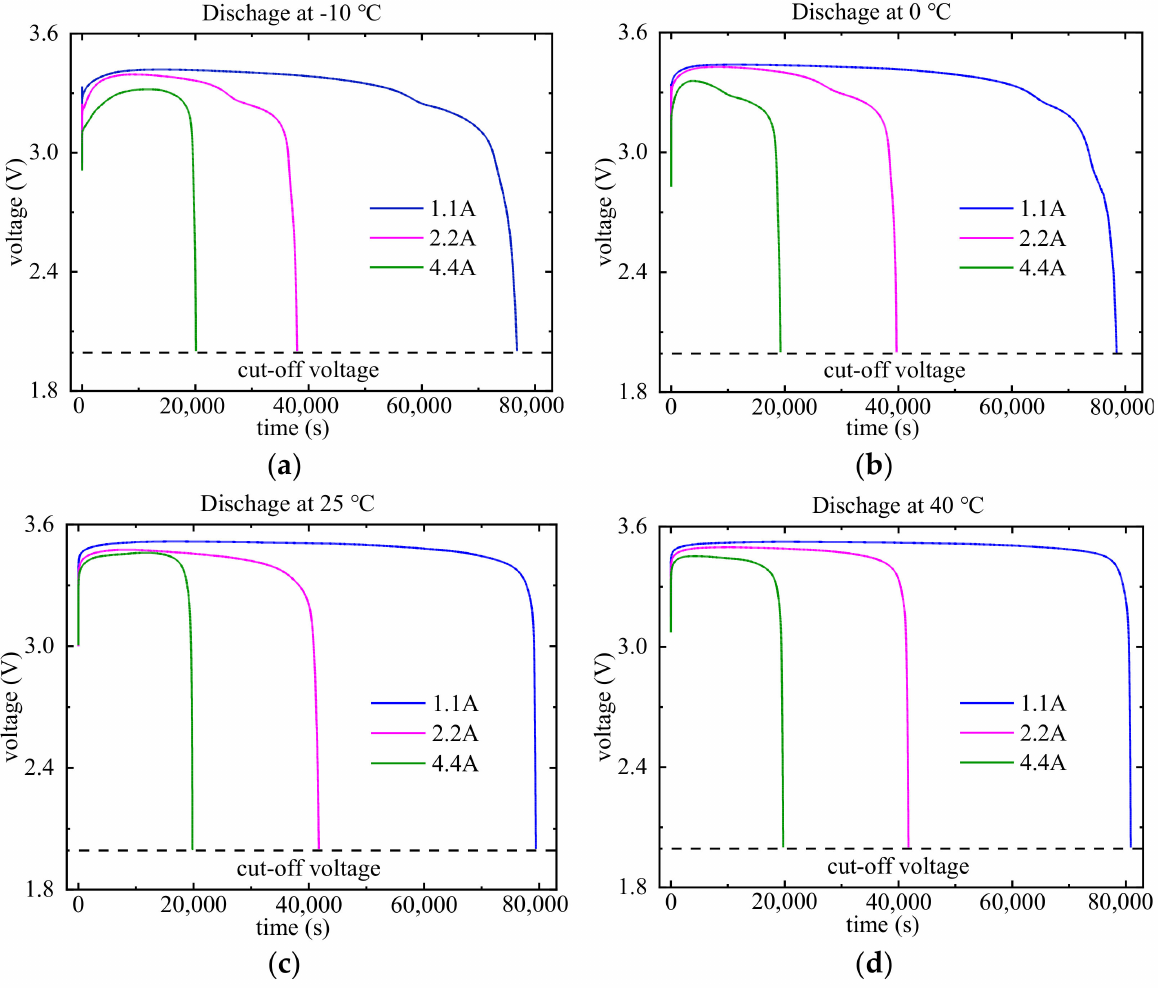
Figure 6. The discharge–voltage curves at different current rates and ( a ) − 10 ◦ C; ( b ) 0 ◦ C; ( c ) 25 ◦ C; and ( d ) 40 ◦